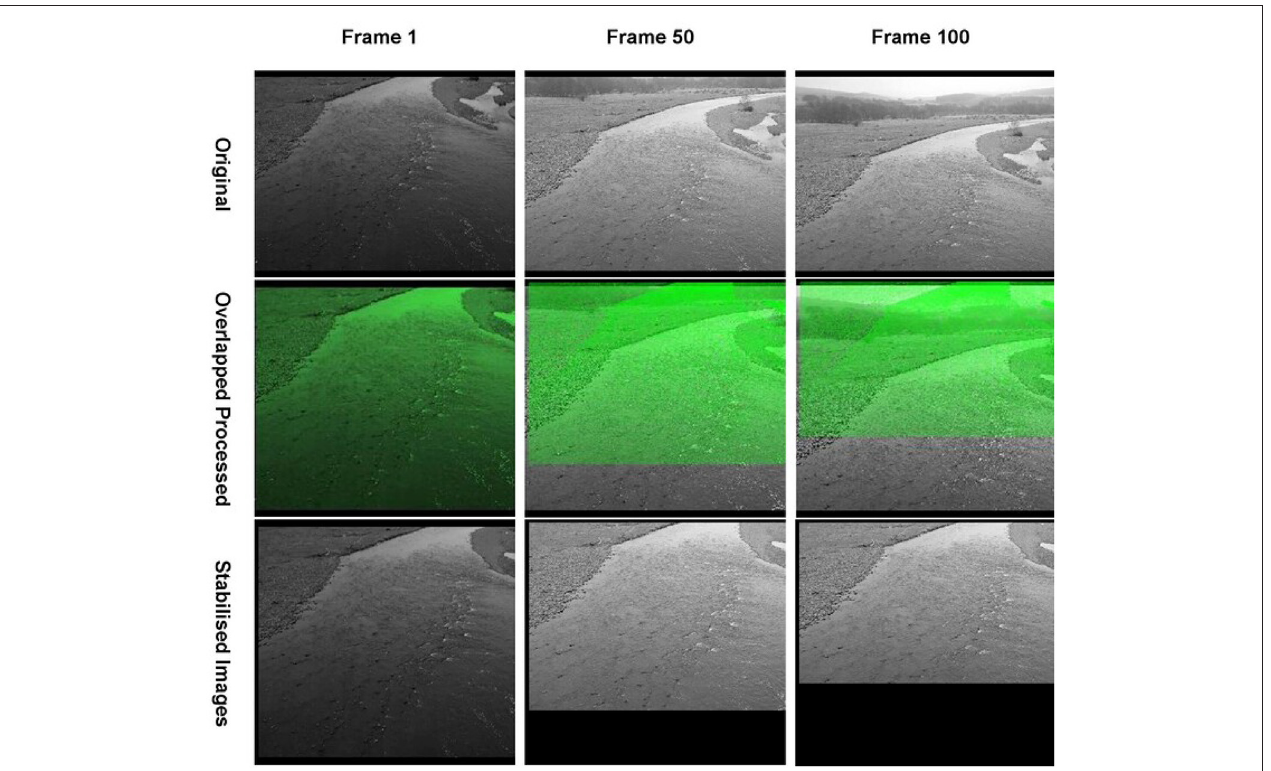
FIGURE 7 | Drone movement shown by overlapping stabilised frames onto original frames. The green mask seen on the processed row highlights where the stable image is within frame, with the final stabilised images cropping all unstable edges.